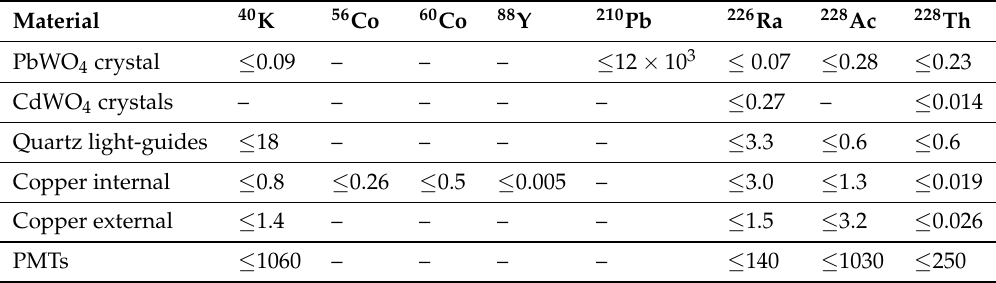
Table 1. Radioactive contamination (mBq/kg) of the materials of the low-background set-up estimated by using the fit of the energy spectra that are presented in Figure 7. Upper limits are given at 68% C.L. Material 40